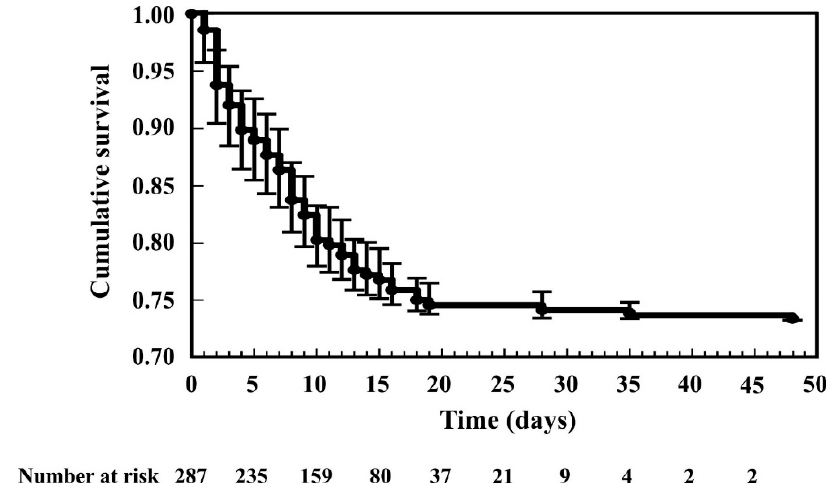
Figure 2. The Kaplan–Meier curve depicts the in-hospital survival rate (value ± 95% confidence intervals) of all the acute coronary syndrome patients with cardiogenic shock in the first 48 days. The one-year mortality of ACS patients with CS was 33.45% (96 patients). The mean time spent in hospital was 11.45 ± 7.86 days, with an average duration of IABP treatment of 4.82 ± 3.82 days. The number of IABP-related vascular complications was 16 cases (pseudoaneurysm, leg ischaemia, thromboembolic complications, or severe haematoma).